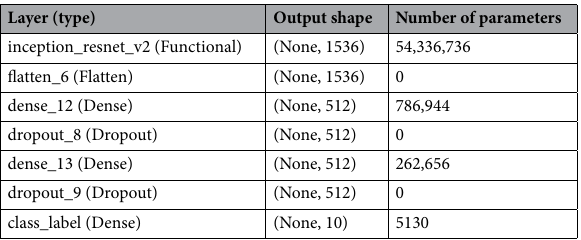
Table 2. The InceptionV2 model with 55,330,922 trainable parameters; the weights from ImageNet training have been preserved and a series of dense and dropout layers added to match the present 10-class classification problem.